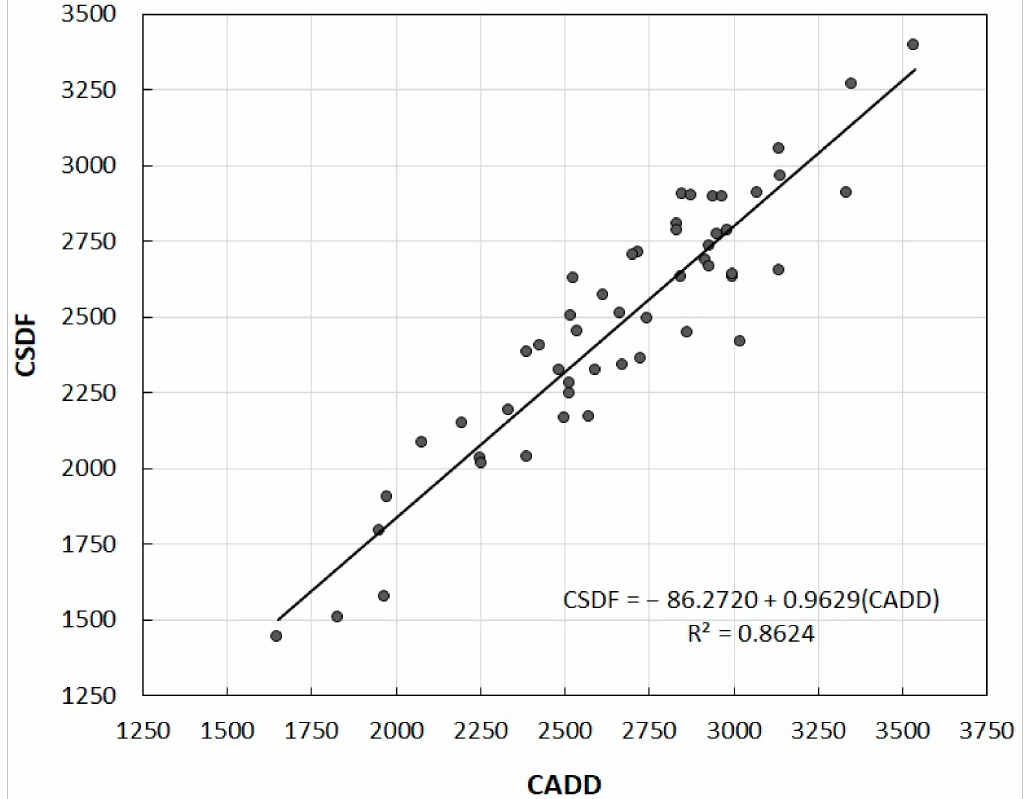
Figure 3. Relationship between cumulative annual surface degree days >0 ◦ C of forest covered areas (CSDF) derived from MODIS images and cumulative annual degree days >0 ◦ C (CADD) derived from air temperature observed by meteorological stations in dominant vegetation